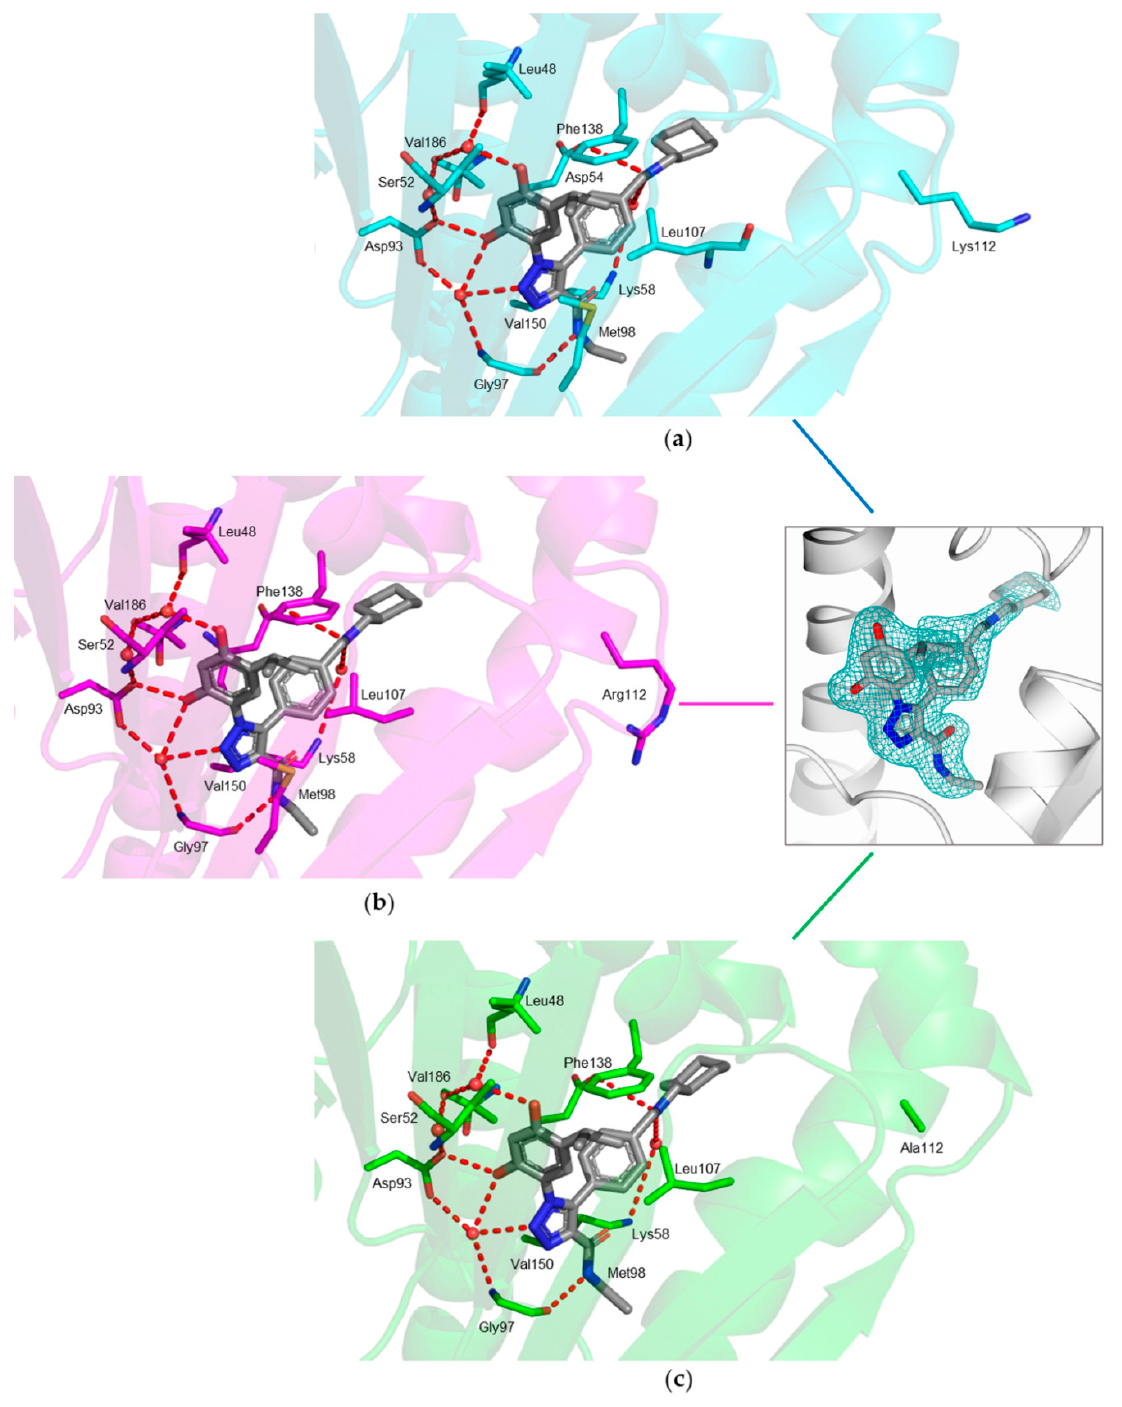
Figure 2. Active-site view of ( a ) hHsp90-NTD (cyan cartoon and carbons, residues in sticks) in complex with JMC31 (in sticks, grey carbons); ( b ) hHsp90-NTD K112R variant (magenta cartoon and carbons, residues in sticks) in complex with JMC31 (in sticks, gray carbons); ( c ) hHsp90-NTD K112A variant (green cartoon and carbons, residues in sticks) in complex with JMC31 (in sticks, gray carbons). The fitting of the JMC31 (in sticks, gray carbons) in the omit map (teal mash, contoured at the 3.0 σ level) is shown in the inset. In all figures, H-bonds are displayed as red dashed lines and water molecules as red spheres. Oxygen atoms are colored red, nitrogen blue, and sulfur yellow.